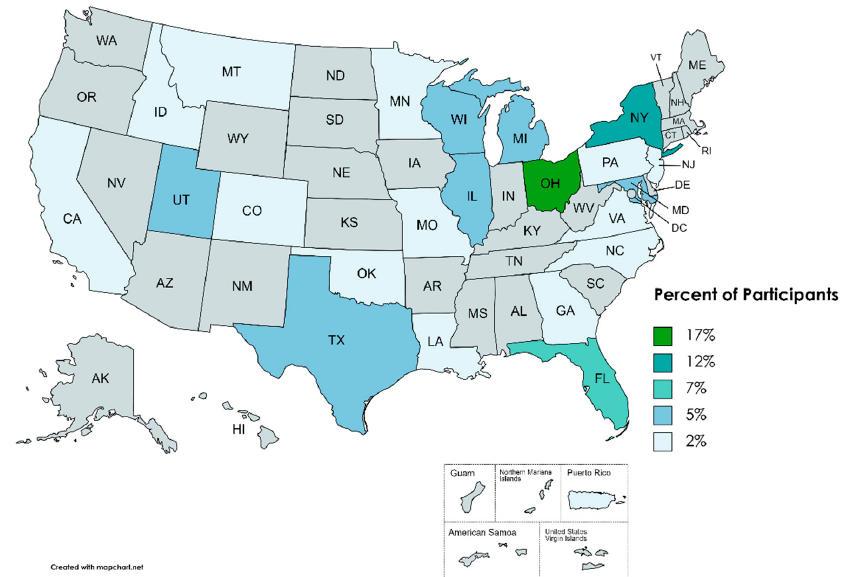
Figure 2. Dietetic intern participants’ ( n = 42) location of internship and percentage of participants that had internships in that location. Table 1. Themes, subthemes, and representative quotes from dietetic interns ( n = 42) regarding fac ‐ tors that influenced their dietary intake during supervised practice.